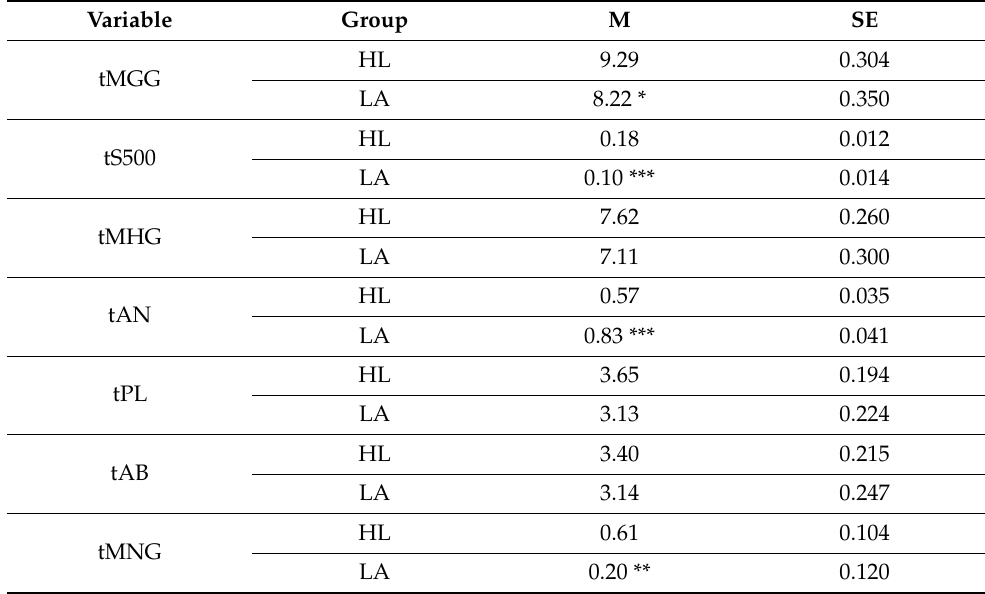
Table 4. Milking time (min) traits of cows by health status and lameness level ( n =